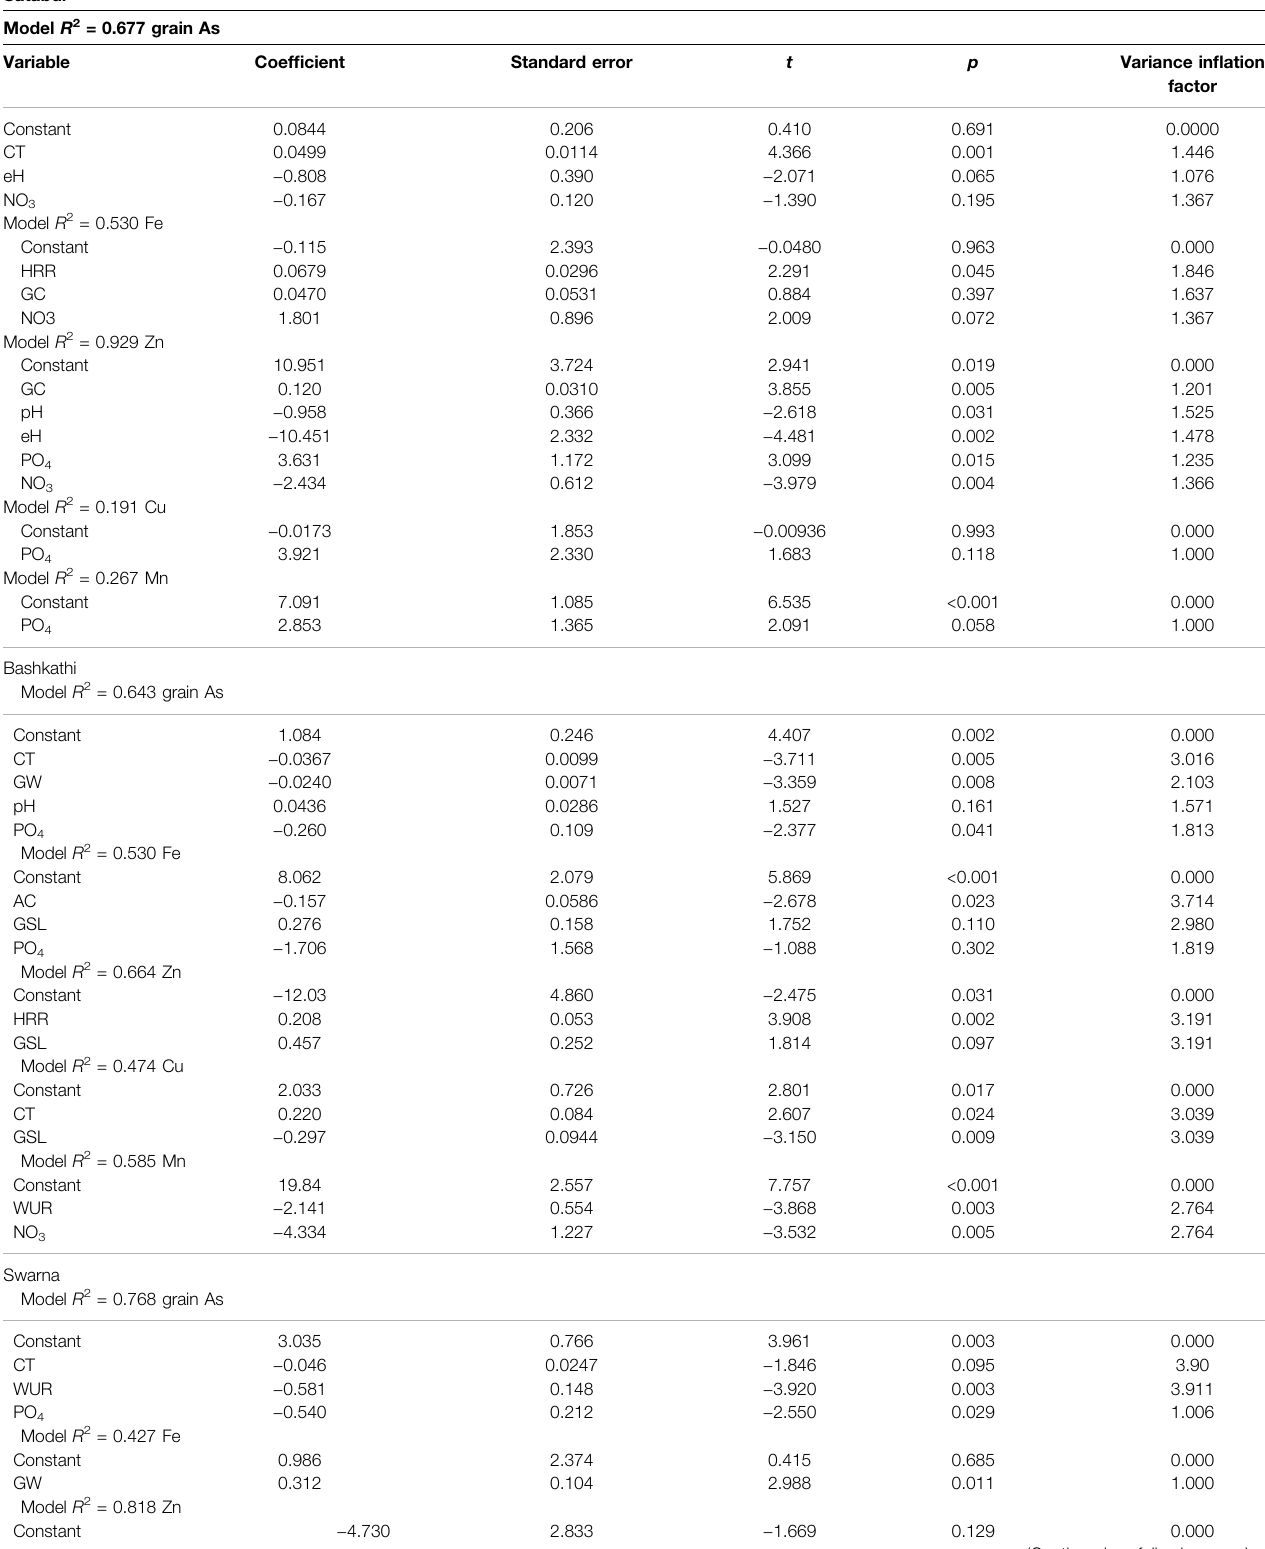
TABLE 2 | Best subset regression among grain quality and soil parameters for rice variety(ies) with respect to studied As and other micronutrients.